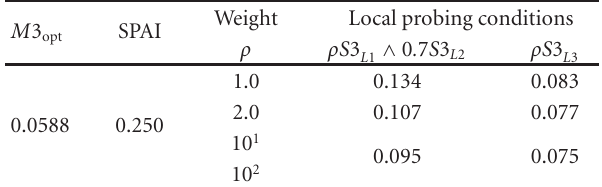
Table 1: Smoothing factors by using M 3 opt (16), SPAI, and MSPAI with local probing conditions for the constant coe ffi cient system A 1 of order n = 10 3